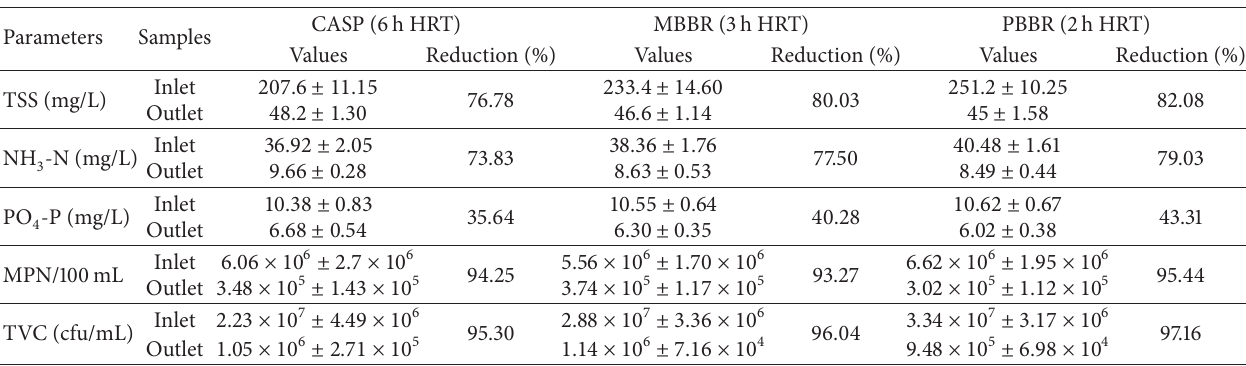
Figure 4: SEM photographs of the biofilm-forming bacteria on the surface of the carrier media before treatment at 73x magnification (a) and after treatment at 5 kx magnification: MBBR (b) and PBBR (c). Table 3: Summary of the average percentage removal of pollutants from the biological treatment processes at optimum operating conditions.